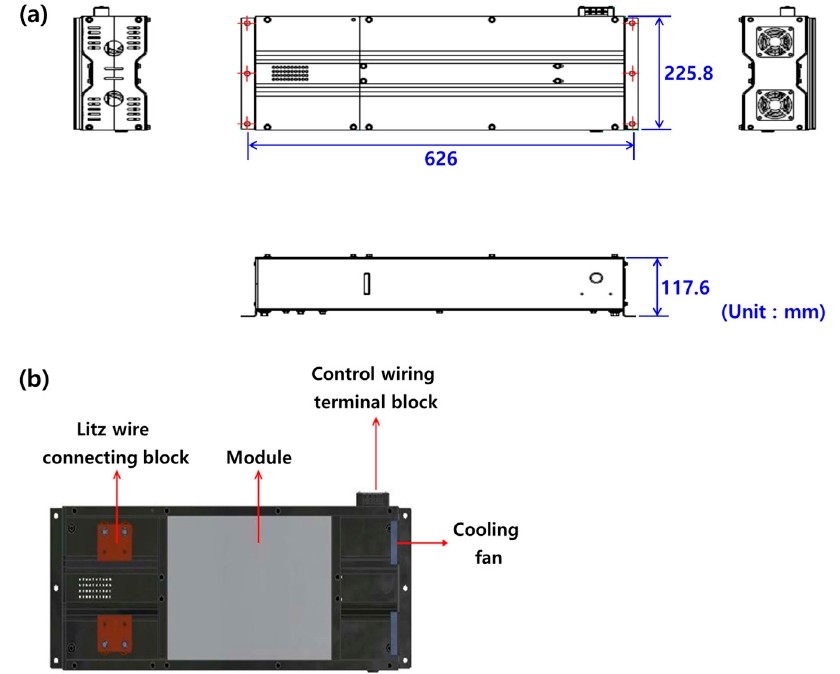
Figure 3. ( a ) The external dimensions of the manufactured prototype of the pickup module, ( b ) the internal layout of the pickup module. Several essential parts, such as the cooling fan, control wiring terminal block, and Litz wire connecting block, are installed inside of the product.